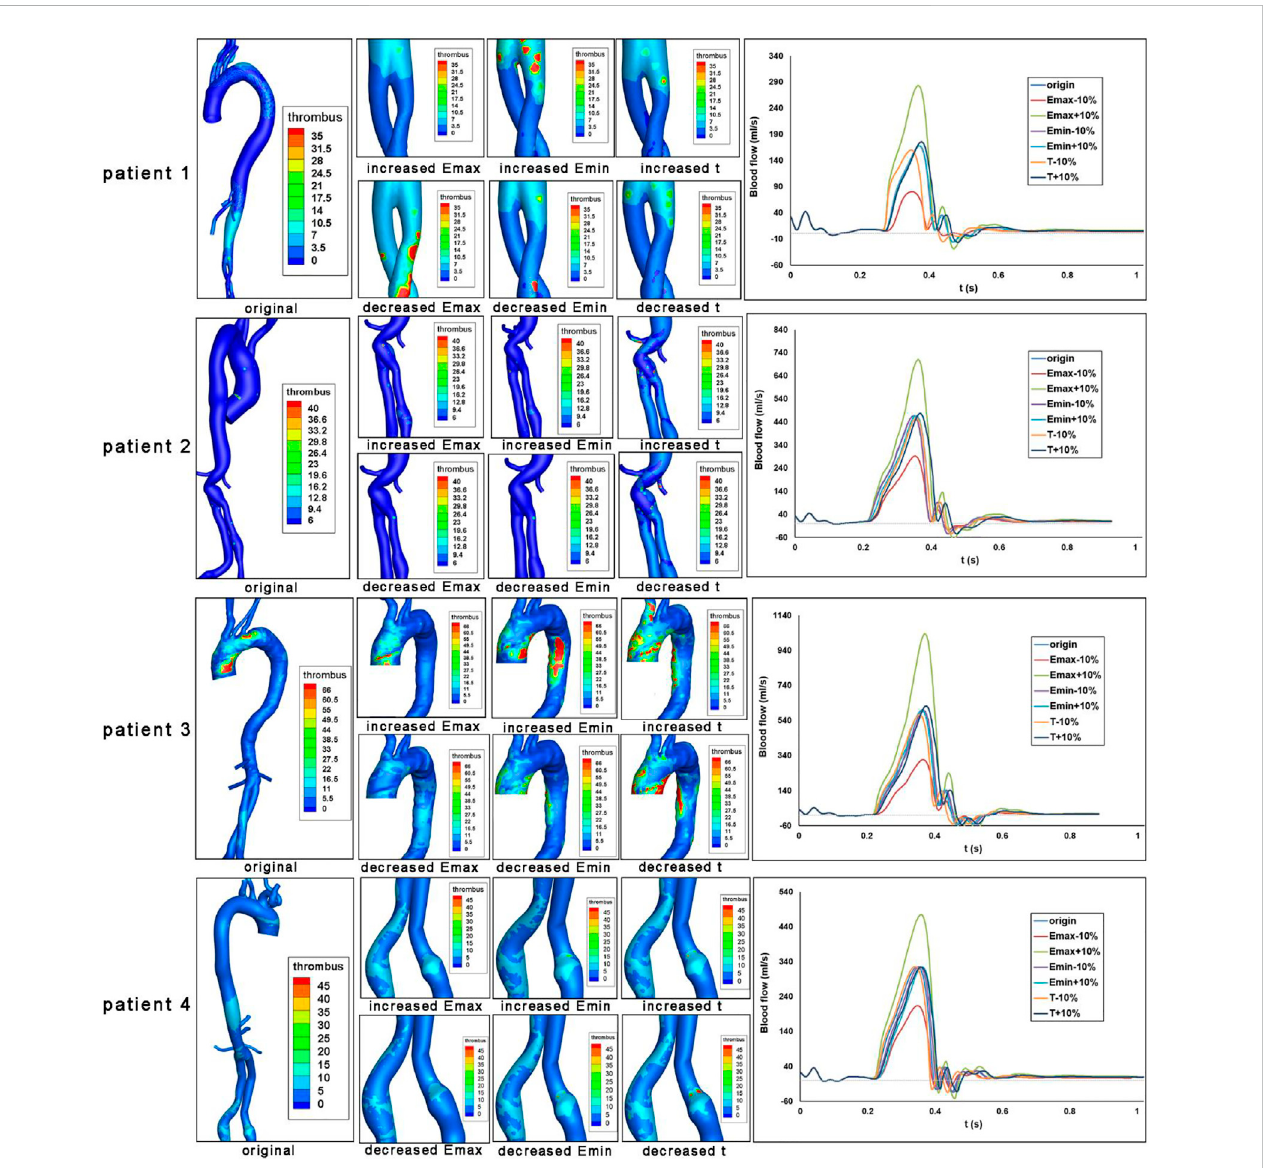
Impactofheartfunctionalterationonthrombosisatcriticalpositions.Boundedplatelets(BP)levelsunderdifferentheartconditionswereshownforeach patient. Aortic blood fl ow values over a cardiac cycle were also